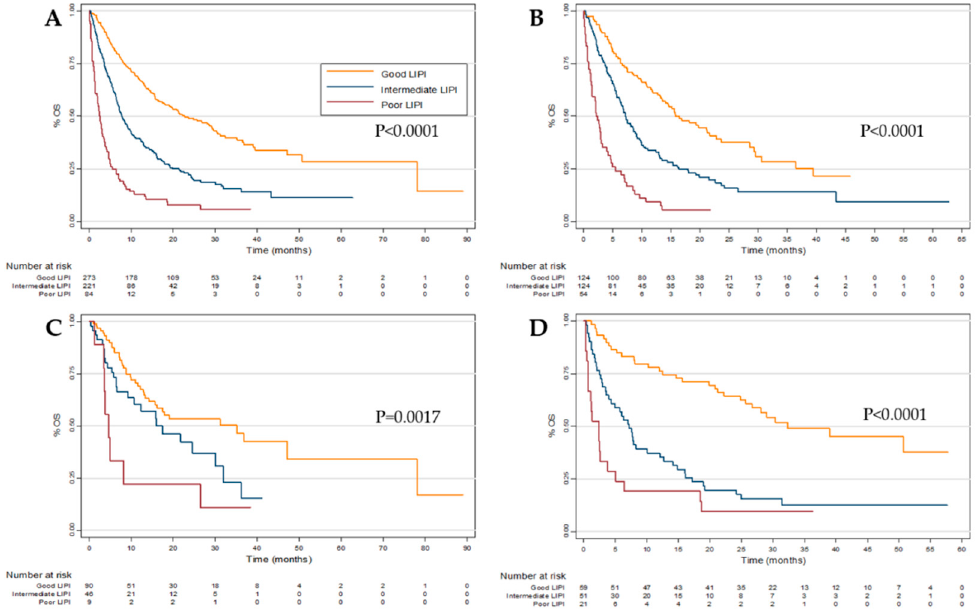
Figure 1. Overall survival (OS) according to Lung Immune Prognostic Index (LIPI) group in the ( A ) pooled, ( B ) Non-small cell lung cancer (NSCLC), ( C ) Renal cell carcinoma (RCC) and ( D ) melanoma cohorts.